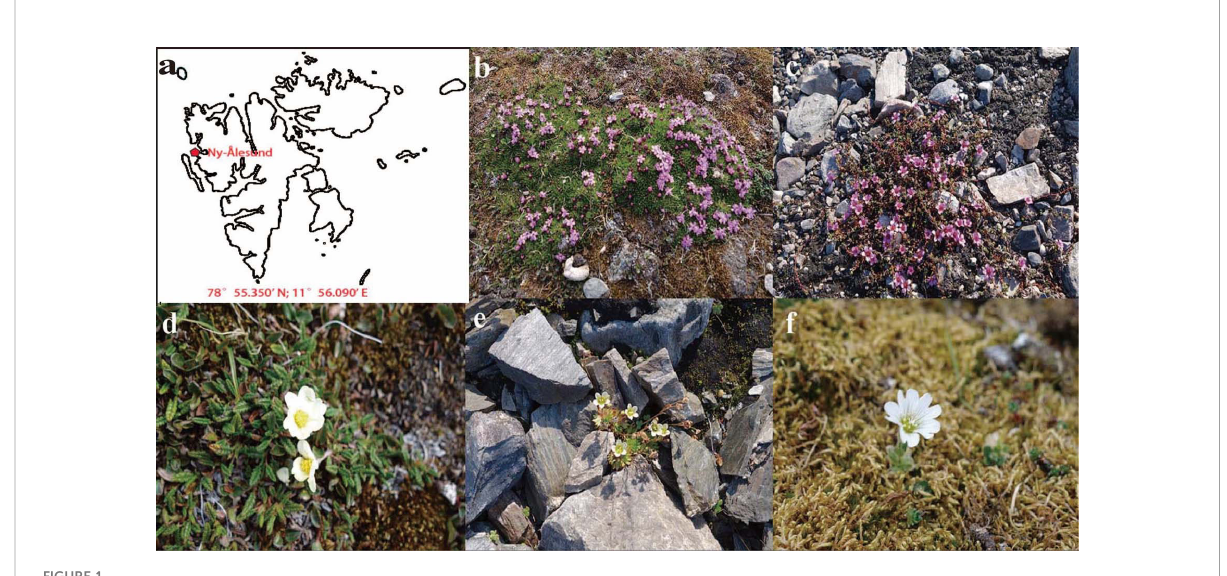
FIGURE 1 Location of Ny-Ålesund and fl ower samples. (A) Location of Ny-Ålesund, Svalbard Archipelago (B – F) Flower samples; (B) Silene acaulis ; (C) Saxifraga oppositifolia ; (D) Dryas octopetala ; (E) Saxifraga cespitosa ; (F) Cerasticum arcticum